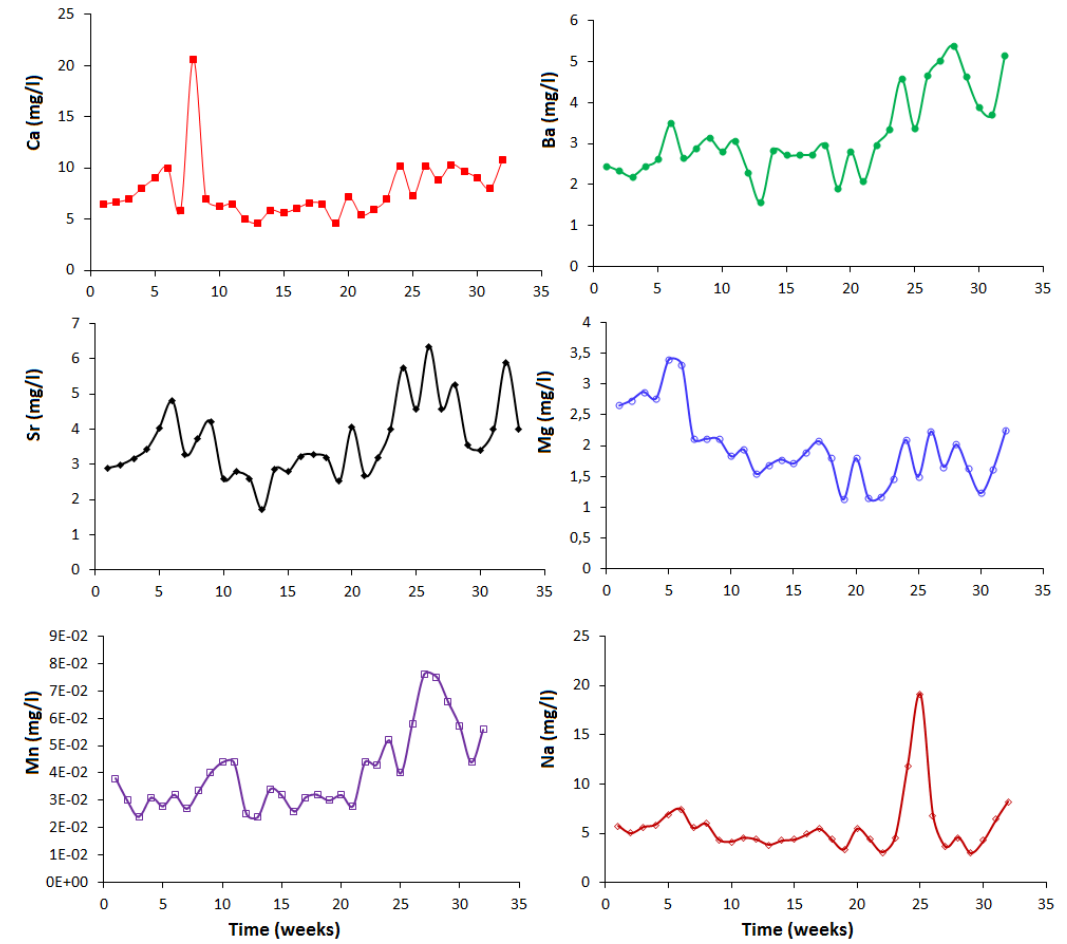
Figure 8. Evolution of Ca, Ba, Sr, Mg, Mn and Na concentrations from weathering cell test.